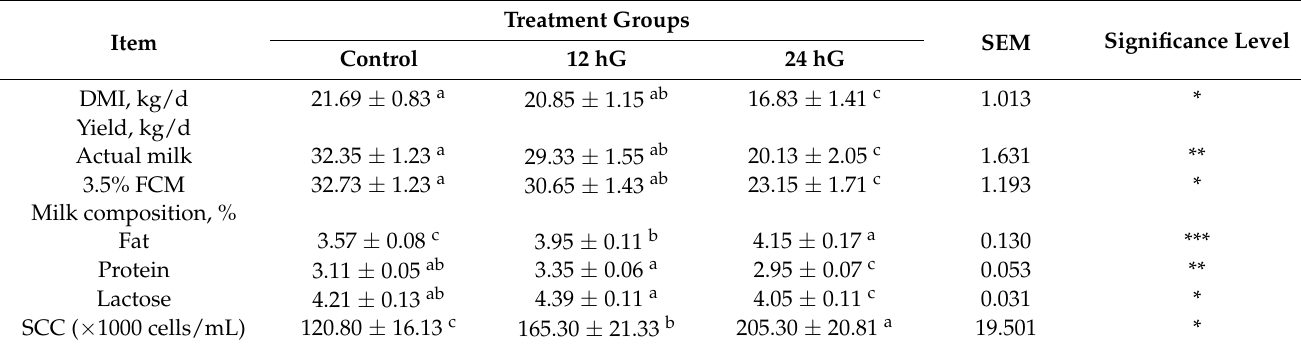
24 hG: 24 h grazing group. a,b,c Values within a row with different superscripts differ